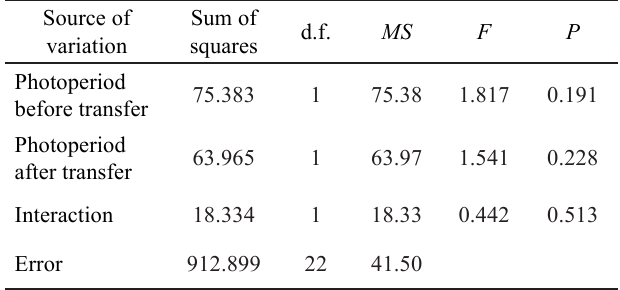
Table 3 . Summary of two-way ANOVA testing for the effects of photoperiods before and after transfer from 15 to 25 °C on the pre-oviposition period in Lasius japonicus .